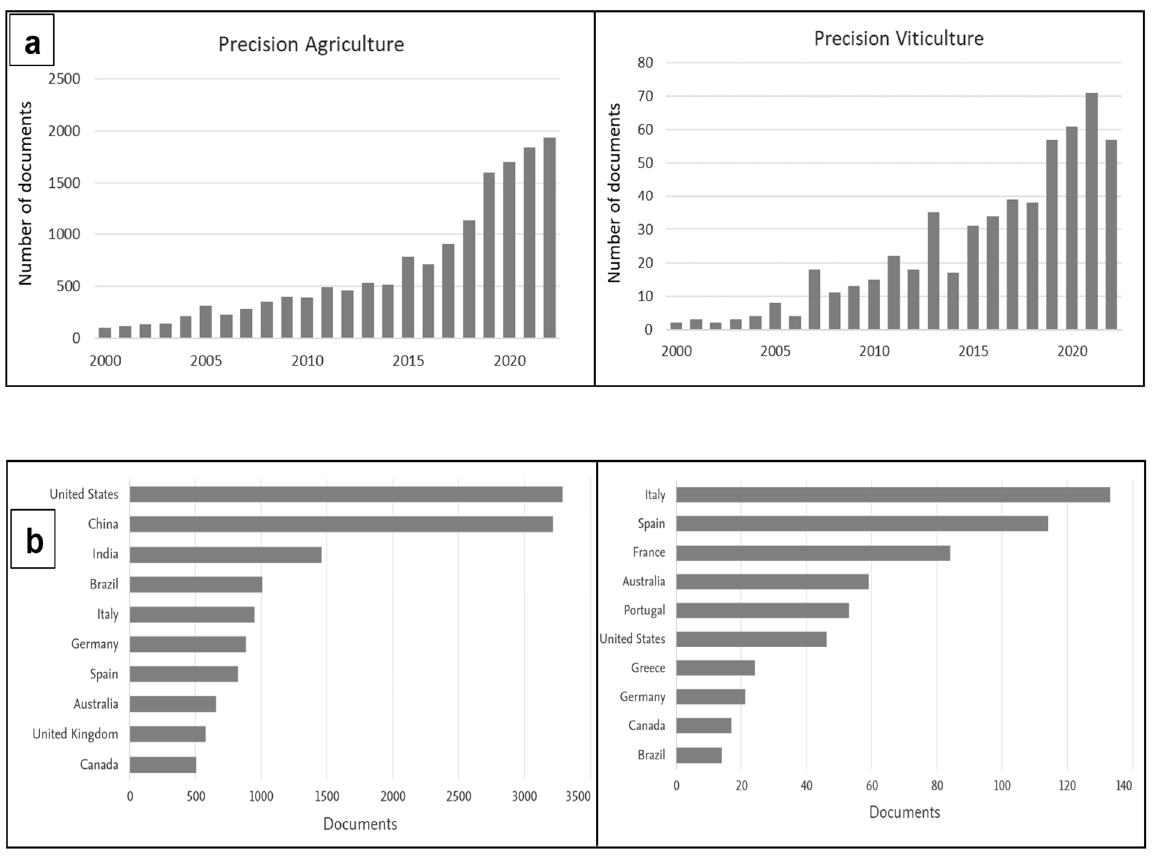
Figure 1. ( a ) — Evolution of the number of publications on the topics of precision agriculture and viticulture; ( b ) Evolution of publications per country; The data were derived through the methodology explained in Section 2 and refer to the time interval between 1999 and 2022. Source: SCOPUS 2022.